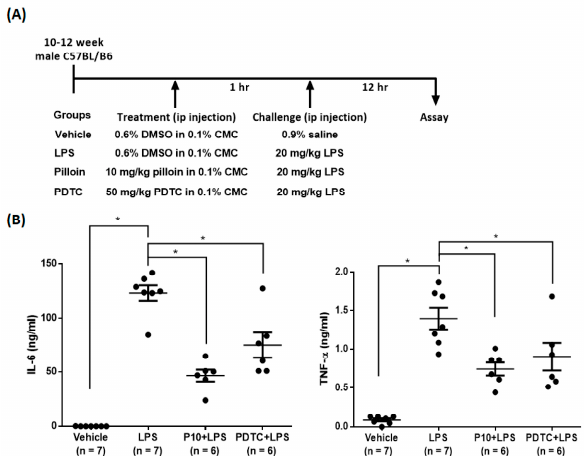
Figure 6. Pilloin reduces the serum level of pro-inflammatory cytokines in LPS-induced septic mice. ( A ) Experimental scheme for LPS-induced sepsis in mice and drug treatment. ( B ) Pilloin reduces the levels of pro-inflammatory cytokines in the serum of LPS-treated mice. Data were collected from mice exposed to various treatments for 12 h after LPS challenge. The production of TNF- α and IL-6 was determined by ELISA respectively. The values are shown as mean ± SEM. * indicates statistically significant ( p < 0.05). CMC: carboxymethyl cellulose.